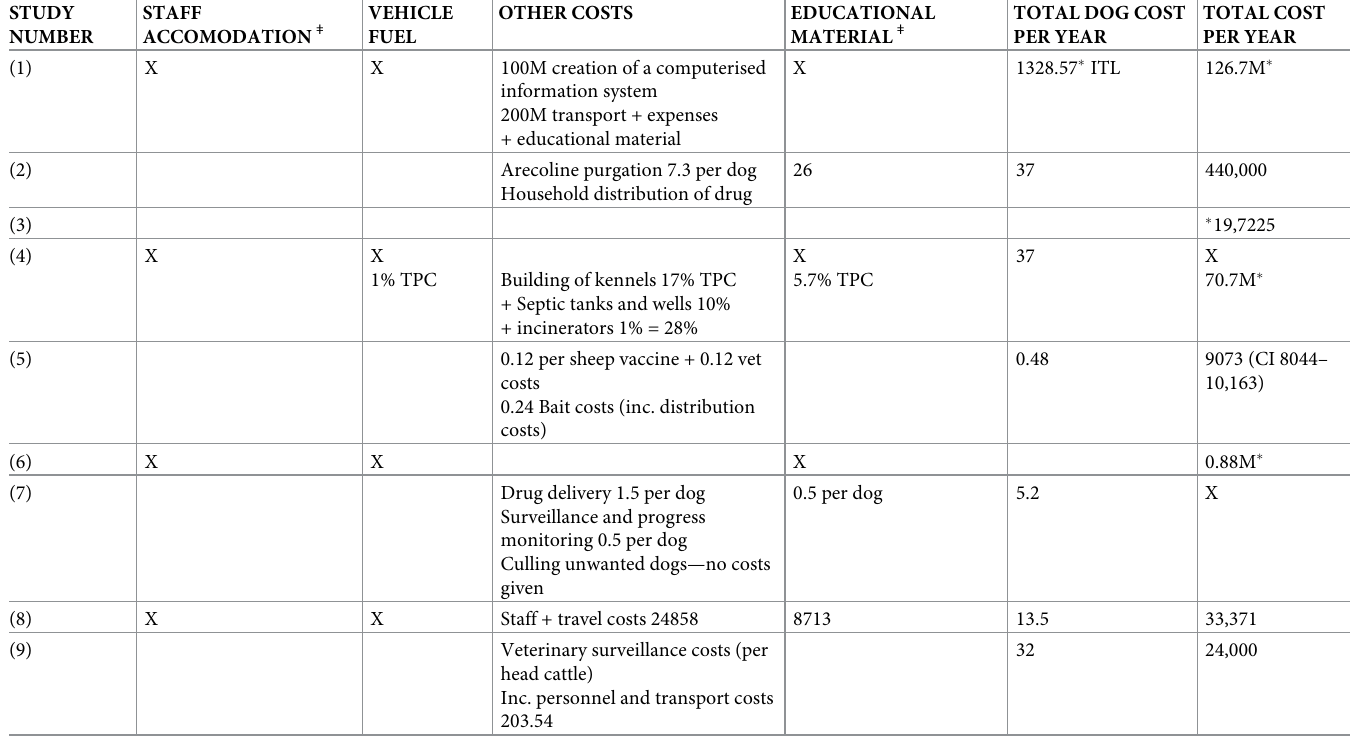
Table 4. Data extraction of costs continued, including total annual costs.